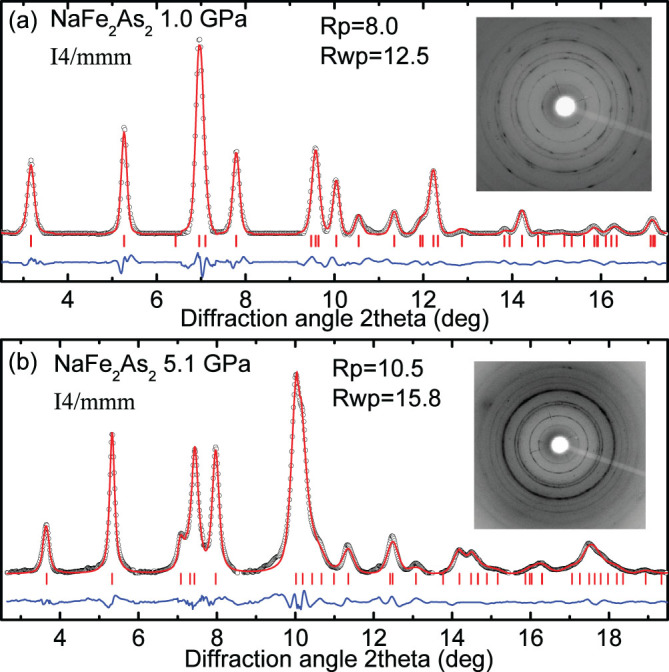
Rietveld refinements for NaFe2As2 at (a) 1.0 GPa and (b) 5.1 GPa.Respective 2D x-ray diffraction images are shown in insets.